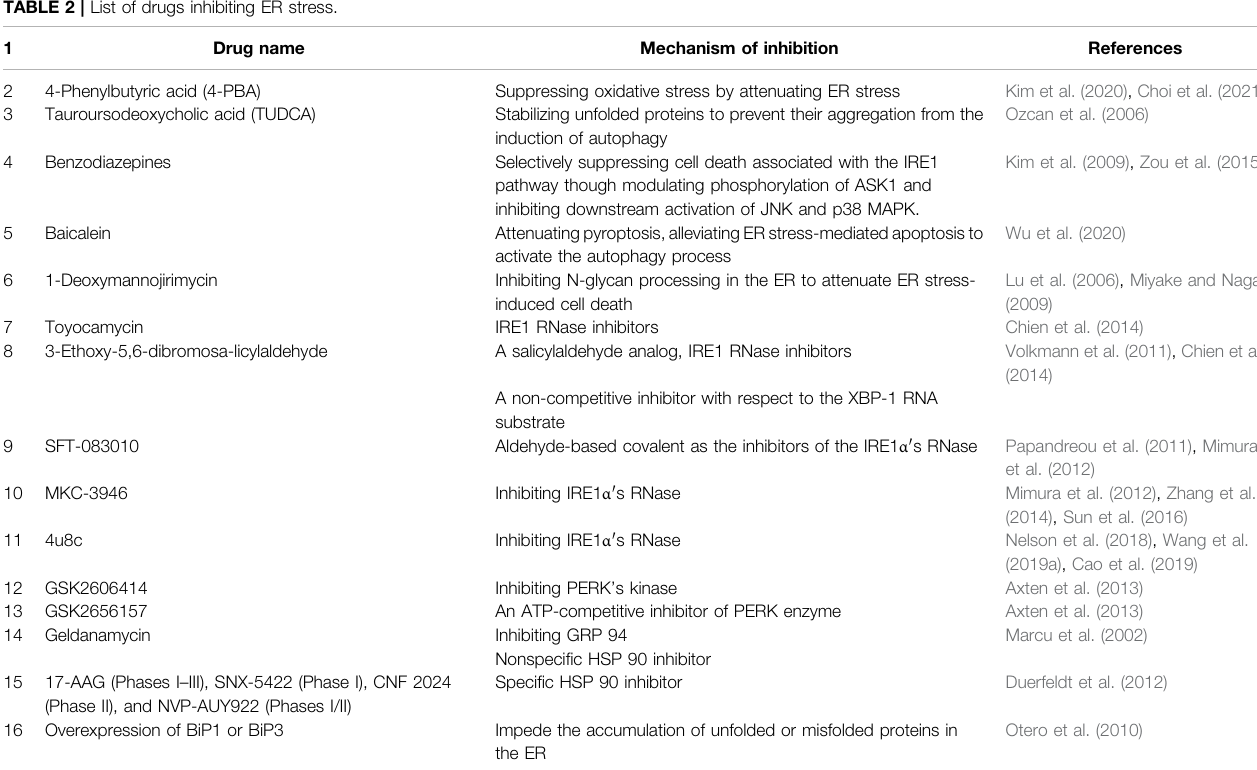
TABLE 2 | List of drugs inhibiting ER